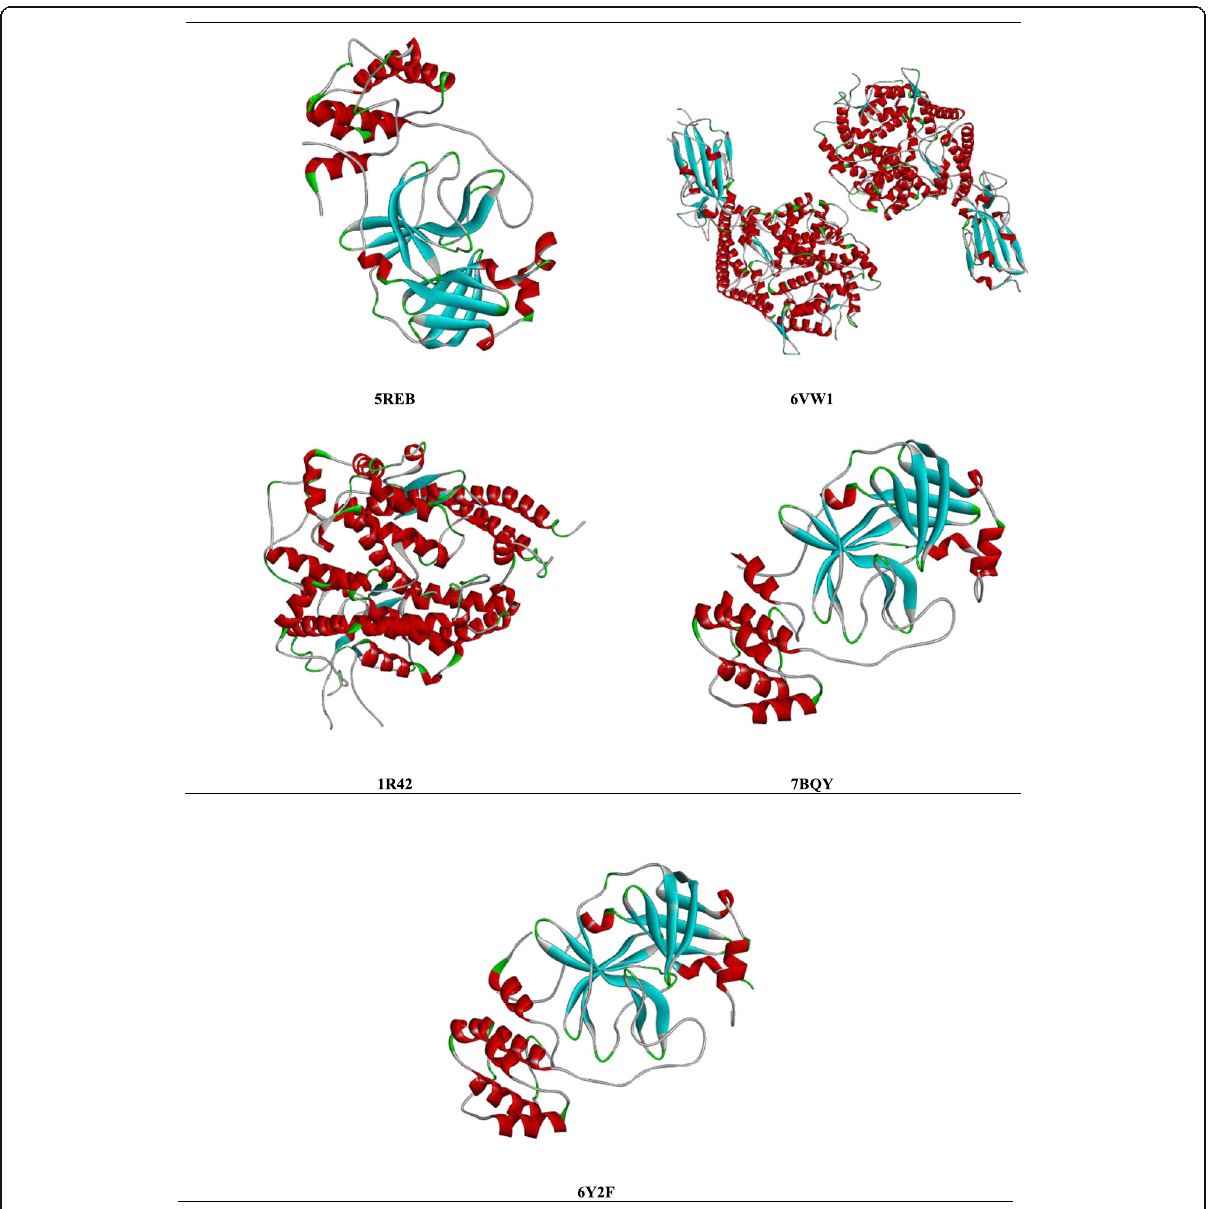
Fig. 2 3D structure of the pure receptors (5REB, 6VW1, 1R42, 7BQY, and 6Y2F) of